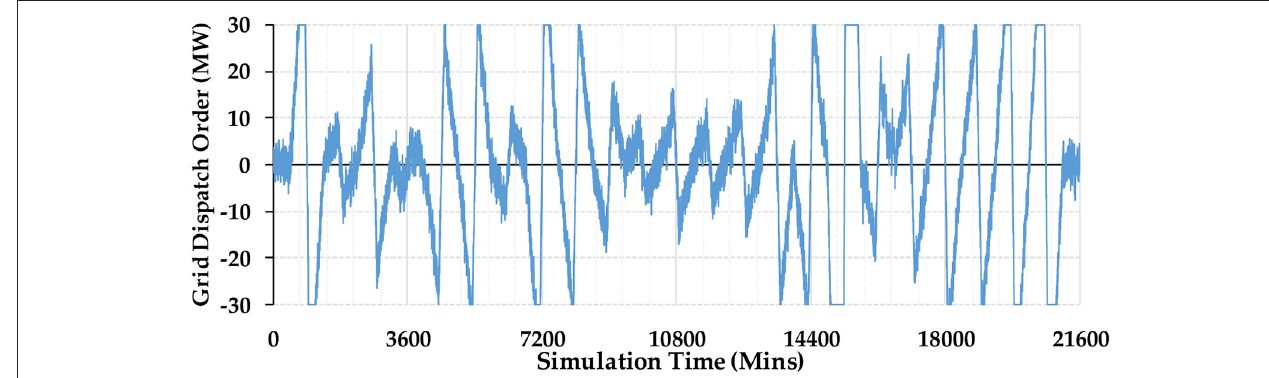
FIGURE 4 | Minutely BESS power inflow/outflow orders from grid operators, P req .